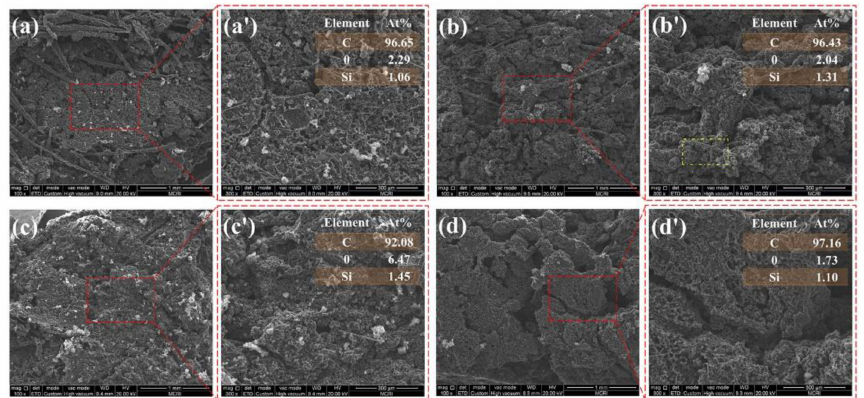
Figure 13. The SEM images of char layer ablation surface. ((AM/HM) 10 : ( a ); (AM/HM) 20 : ( b ); (AM/HM) 40 : ( c ); (AM/HM) 80 : ( d )). ( a (cid:48) , b (cid:48) , c (cid:48) , d (cid:48) ) are the partial magnification of ( a , b , c , d ), respectively.